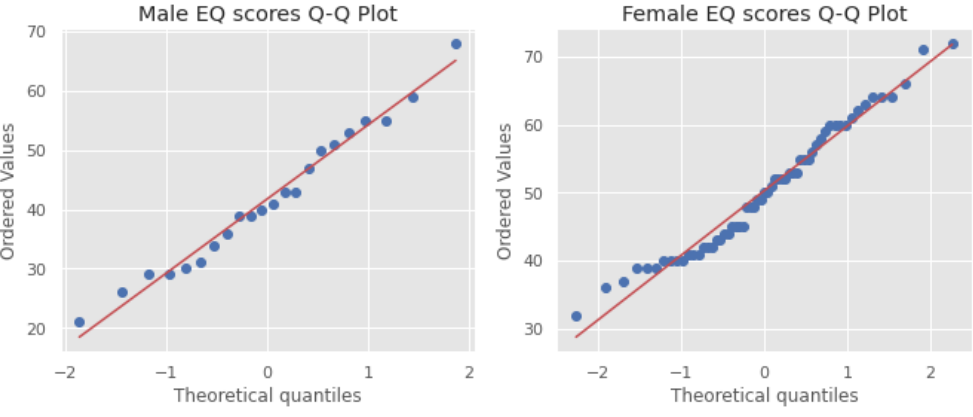
Figure 5. Q–Q plots of empathy quotient (EQ) scores for males and females.